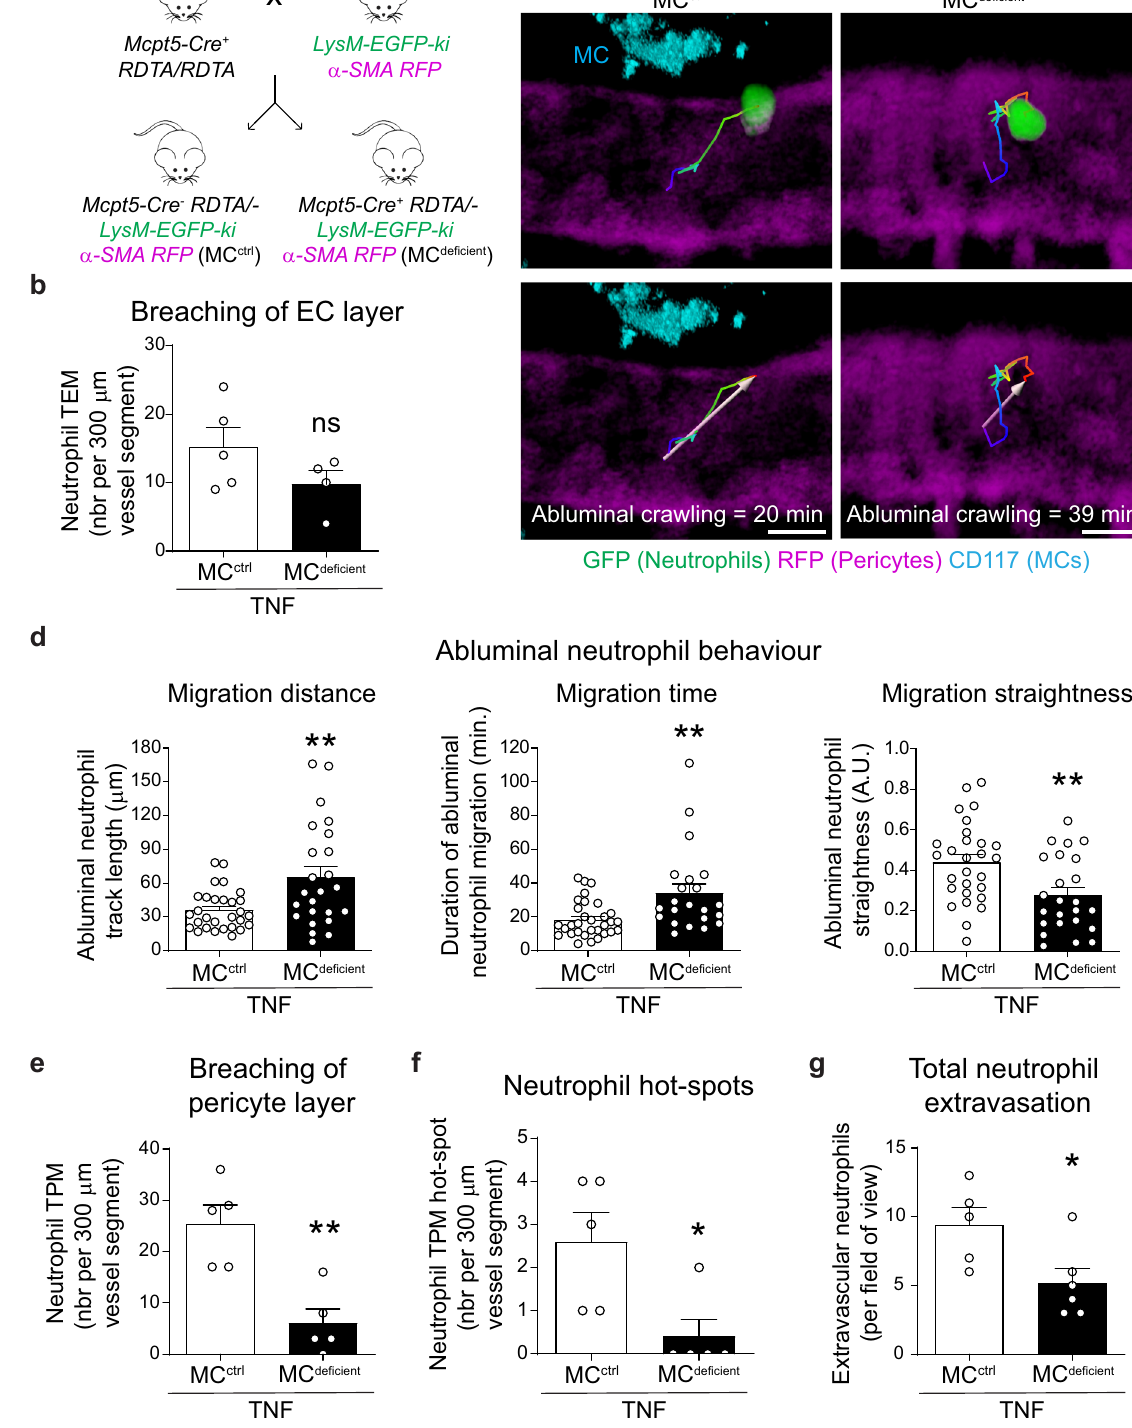
traf fi cking in the sub-EC space and fi nal exit of neutrophils through venular